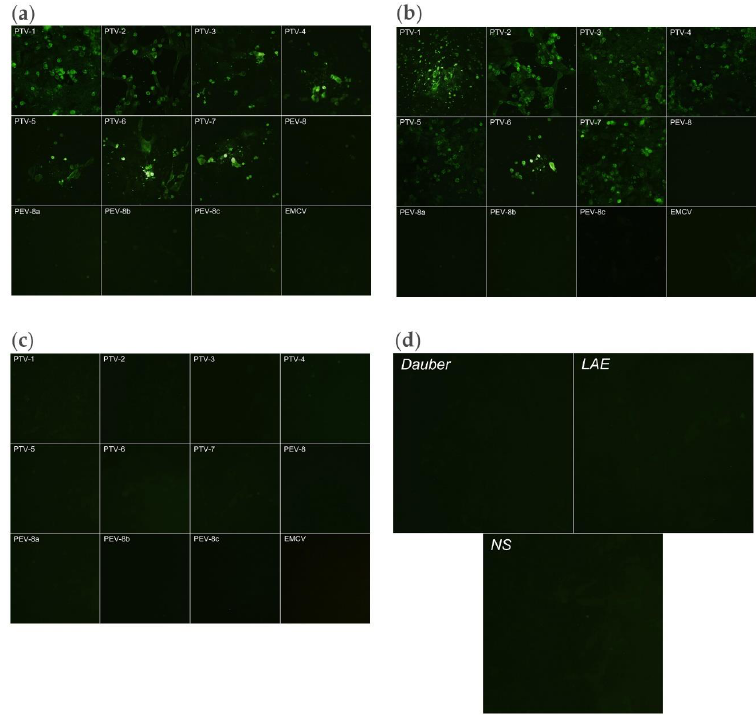
Figure 6. Reaction of the anti-LAE3 antiserum against PTV serotypes 1-7, Sapelovirus strains 436, and EMCV (a Cardiovirus ) in IFA. ( a ) IFA reactions of the viruses tested using a pan-PTV mAb 040/4B1 mouse monoclonal antibody; ( b ) Corresponding IFA reactions using the anti-LAE3 antiserum; ( c ) Corresponding IFA reactions using a normal mouse serum and ( d ) IFA with antiserum to an unrelated (heterologous) mouse anti-enterovirus EV71 used as a negative control. The viruses tested was the PTV-1 PS34 strain (Table 1). Magnification: 200×.